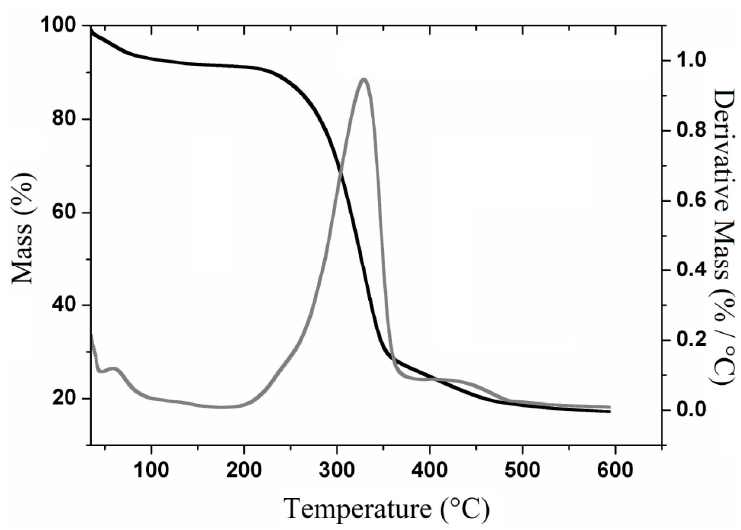
Figure 3. Thermogravimetric curves and their derivatives (TGA-DTG) curves for cellulose extracted from Opuntia ficus-indica L. Miller.